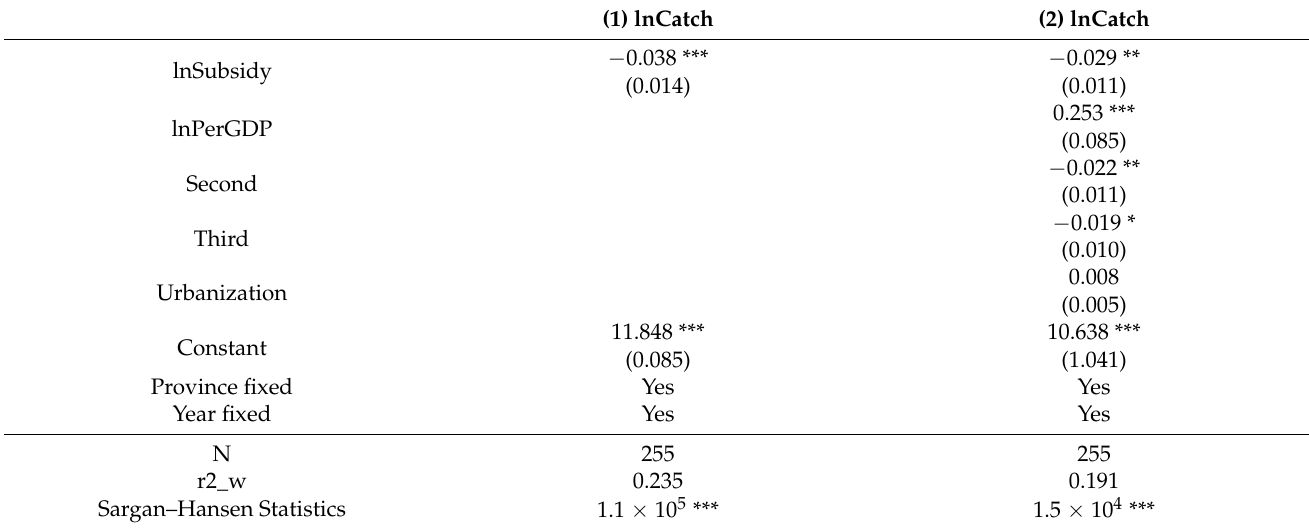
Table 2. Regression results of the full sample